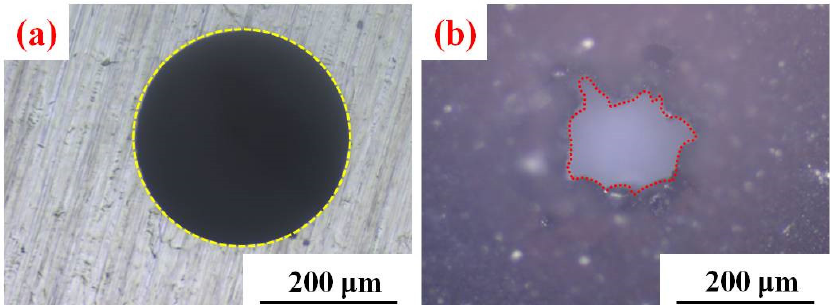
Figure 2. ( a ) Surface morphology of the micro-orifice before test observed by OM ( b ) Surface morphology of the micro-orifice observed by OM after 500 h of the test at 290 °C. The lines in the figure show the counterline of the micro-orifice before and after the test.